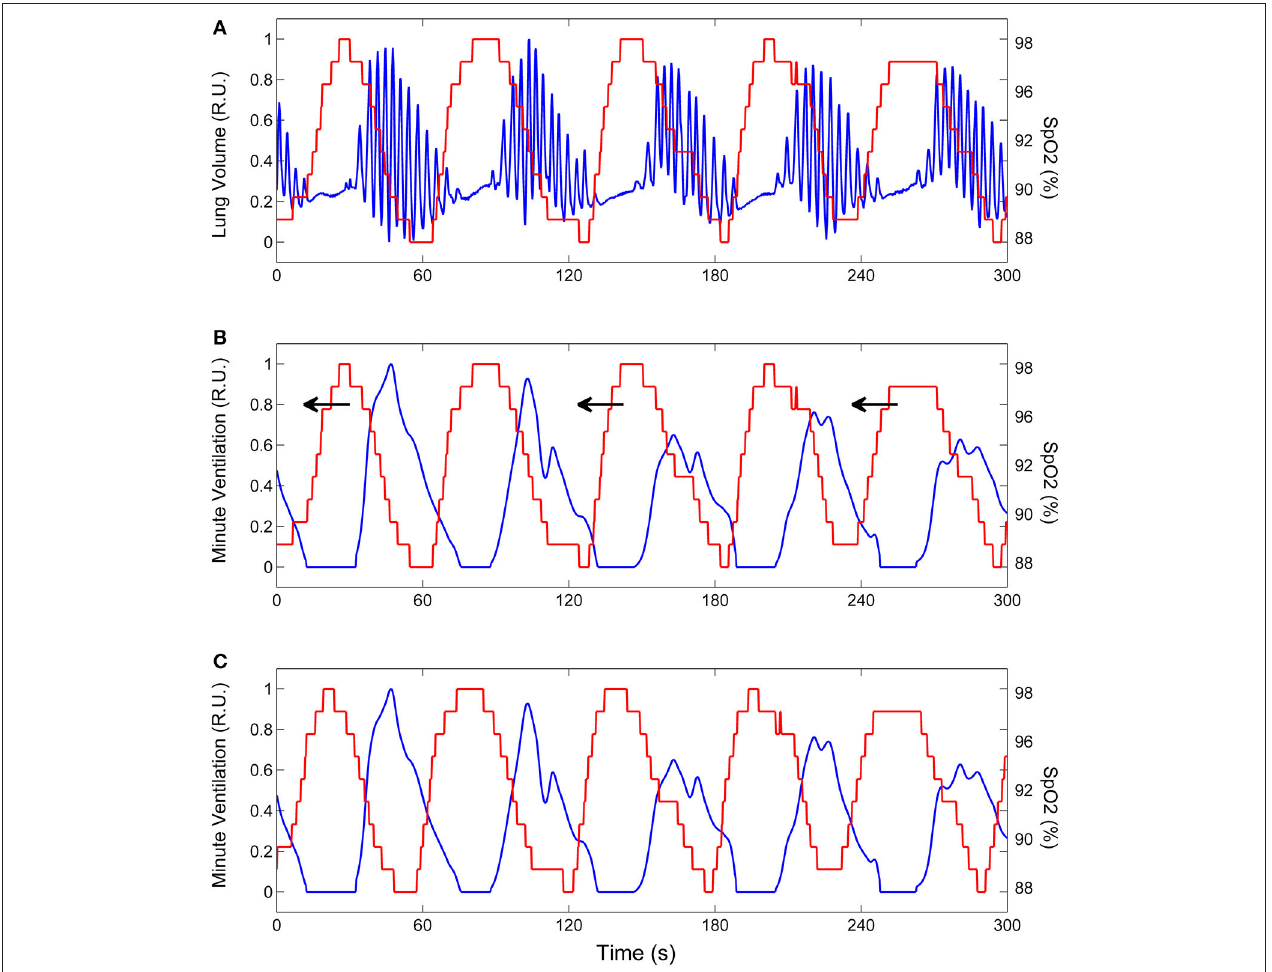
FIGURE 4 | Example of the procedure to estimate the time course of oxygen saturation at carotid chemoreceptors. (A) Lung volume (blue line) and oxygen saturation at the finger (SpO 2 , red line) during CSR-CSA. (B) Same as (A) but the lung volume signal is replaced by the corresponding instantaneous minute ventilation signal. This signal was obtained using a previously developed method ( 29). To estimate the SpO 2 signal at carotid chemoreceptors, the SpO 2 signal at the finger was backward shifted in time as indicated by arrows. (C) Backward shifting was continued until the antiphase condition between the two signals was met (maximum value of the non-linear correlation coefficient between SpO 2 and minute ventilation excluding apneas). The red line shows the estimated SpO 2 signal at carotid chemoreceptors. RU, relative